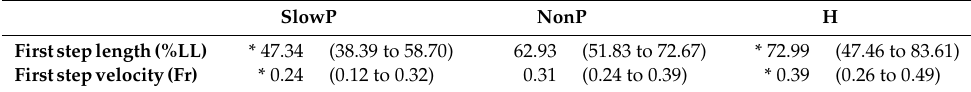
Table 4. First swing parameters. Data are shown as median value (range) for children with slow progressive PCA (SlowP), children with non-progressive PCA (NonP), and healthy children (H). LL: lower limb length; Fr: Froude number; * significant di ff erence between SlowP and H groups, Dunn test p <